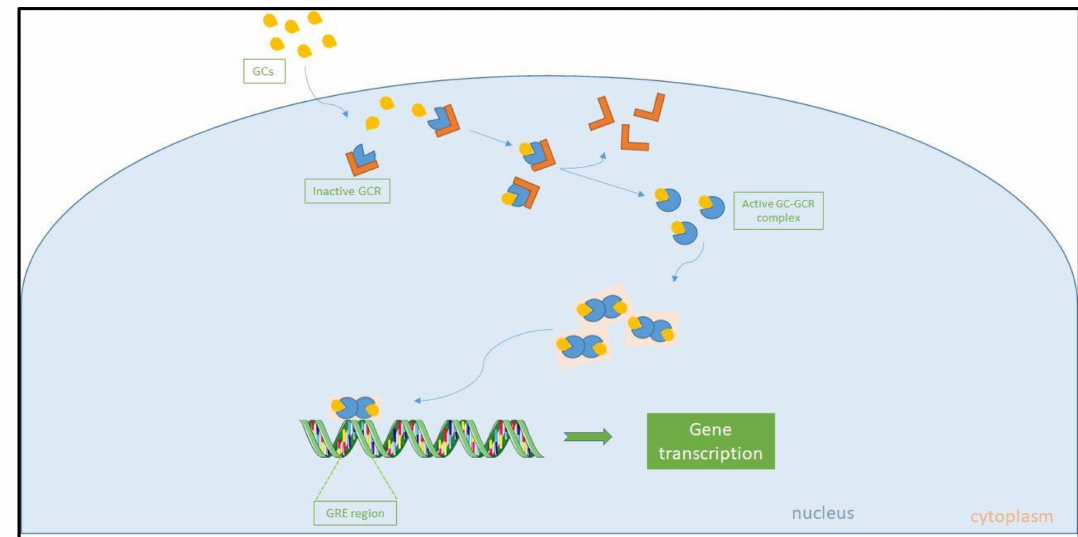
Figure 2. Cortisol signaling through the glucocorticoid receptor. Cortisol signaling is mediated by the glucocorticoid receptor. The receptor–cortisol complex translocates from the cytosol to the nucleus, where it exerts transcriptional activation or repression, the end result being the inhibition of the inflammatory response. GC: Glucocorticoid; GCR: Glucocorticoid receptor; GC–GCR: Cortisol–glucocorticoid receptor complex; GRE: Glucocorticoid responsive